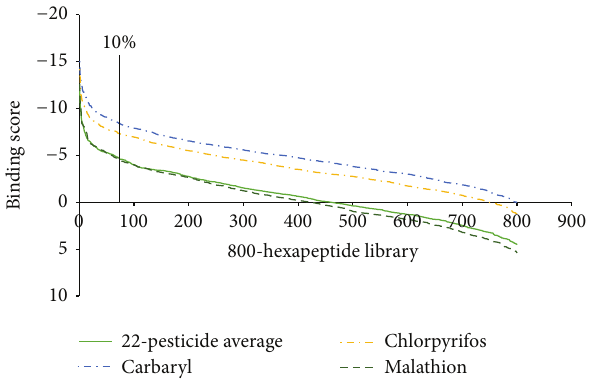
Figure 2: Results obtained in the virtual screening step. Average bindingscoretrendofthe800-hexapeptidelibraryversusthe22pes- ticide ligands, carbaryl, chlorpyrifos, and malathion was reported. The cut-off line of 10% top ranked binding scores hexapeptides (80 hexapeptides) is also